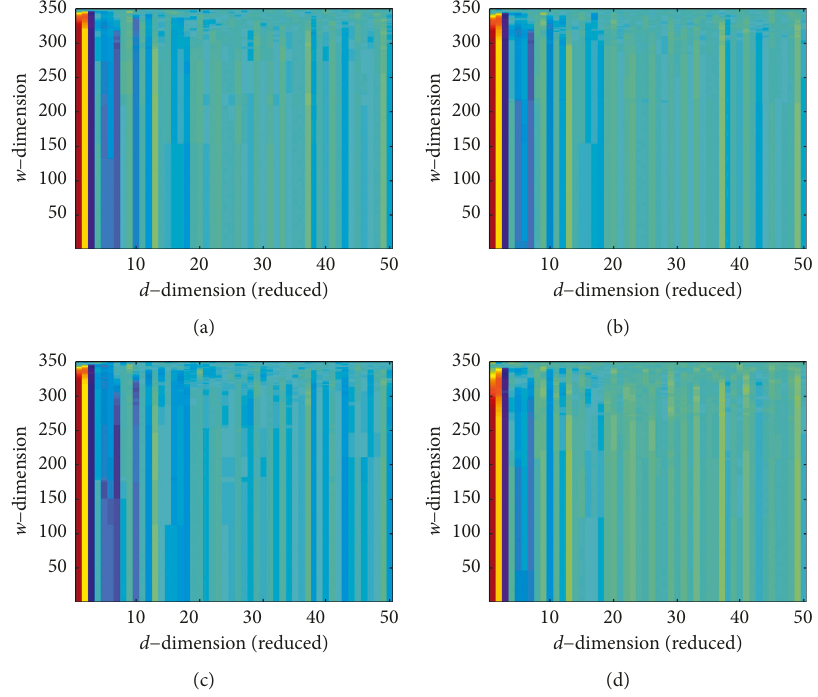
Figure 10: An example of the eigenimages of dataset A: (a) NO; (b) IF; (c) OF; (d) Table 2: Classification results of bearing datasets. Dataset